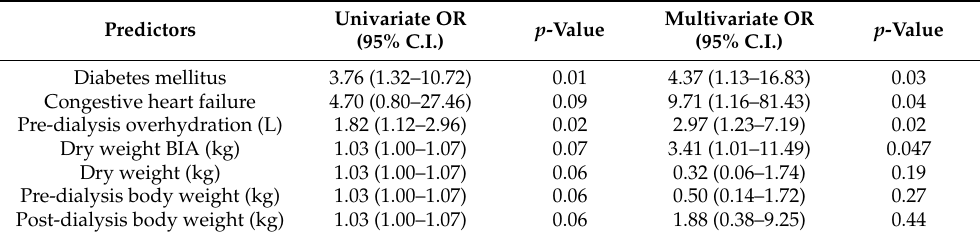
Table 3. The multivariate analyses of the risk factors of unsuccessful reduction in hemodialysis